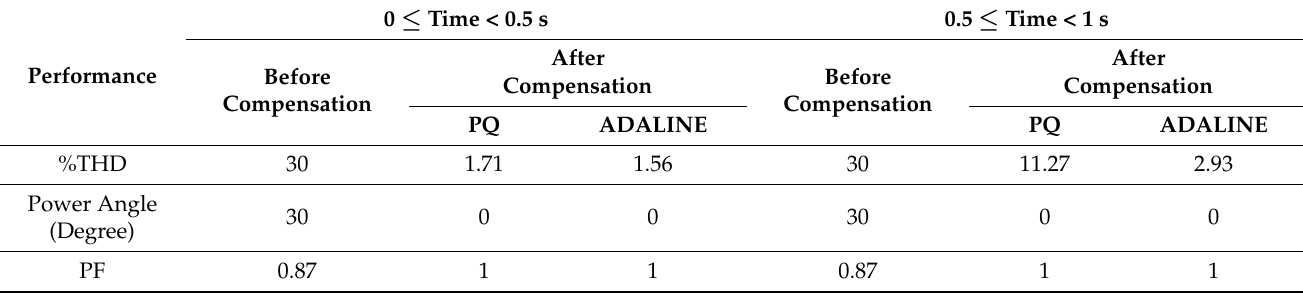
Figure 11. Spectrums of the source current using ADALINE and PQ at intervals 0 ≤ Time < 0.5 s: ( a ) Before compensation; ( b ) After compensation with ADALINE method; ( c ) After compensation with PQ method. Table 3. The average performance value for Case